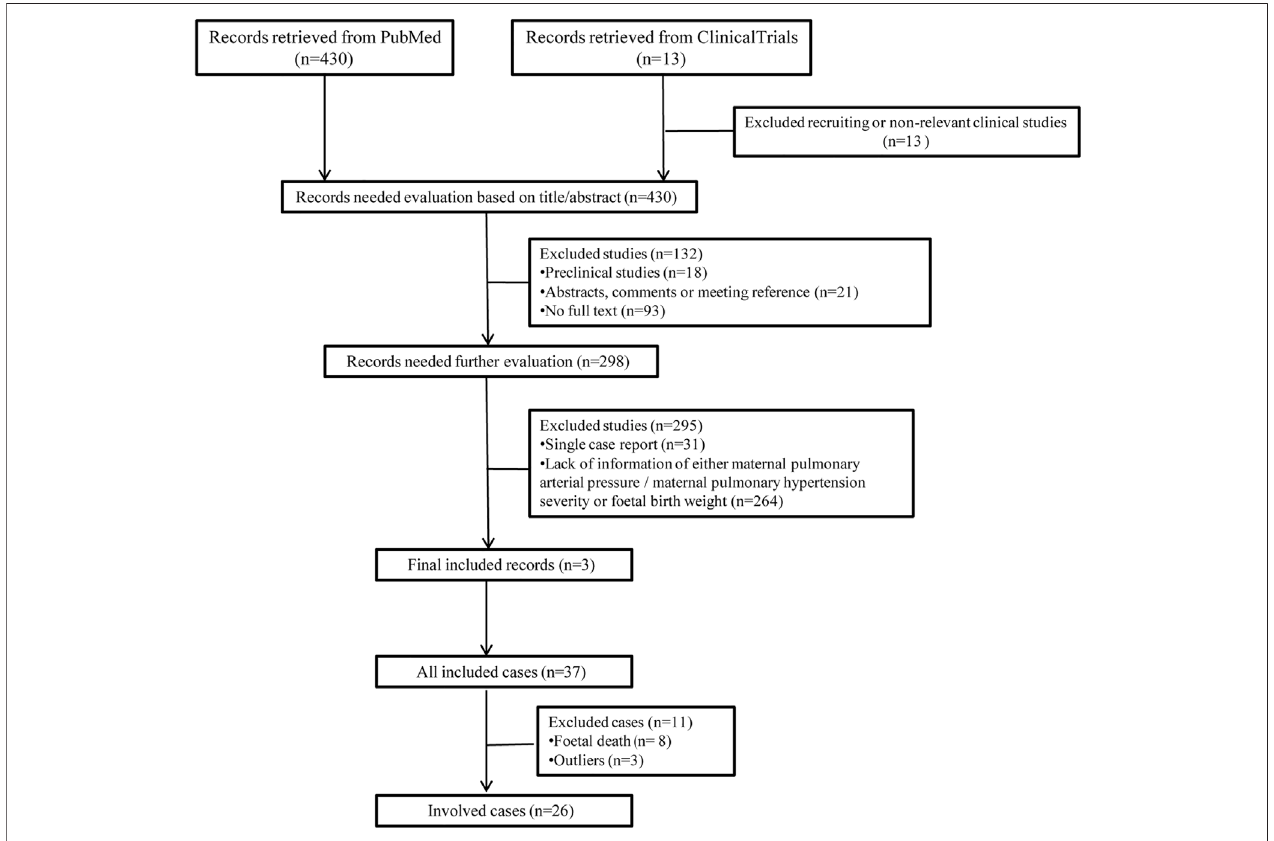
FIGURE 2 | Flowchart of literature selection and case